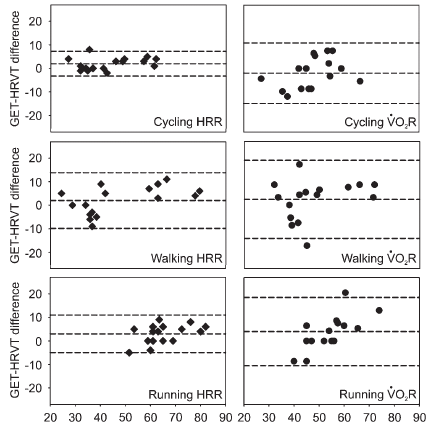
Figure 2. Bland-Altman plots showing within-subject differences between the gas exchange threshold (GET) and heart rate variability threshold (HRVT) plotted against means of GET and HRVT for percentage heart rate reserve (%HRR) and percentage : : VO 2 R) obtained in the cardiopulmonary exercise VO 2 reserve (% tests (cycling, walking, and running). The dashed lines represent the mean bias and 95% limits of agreement